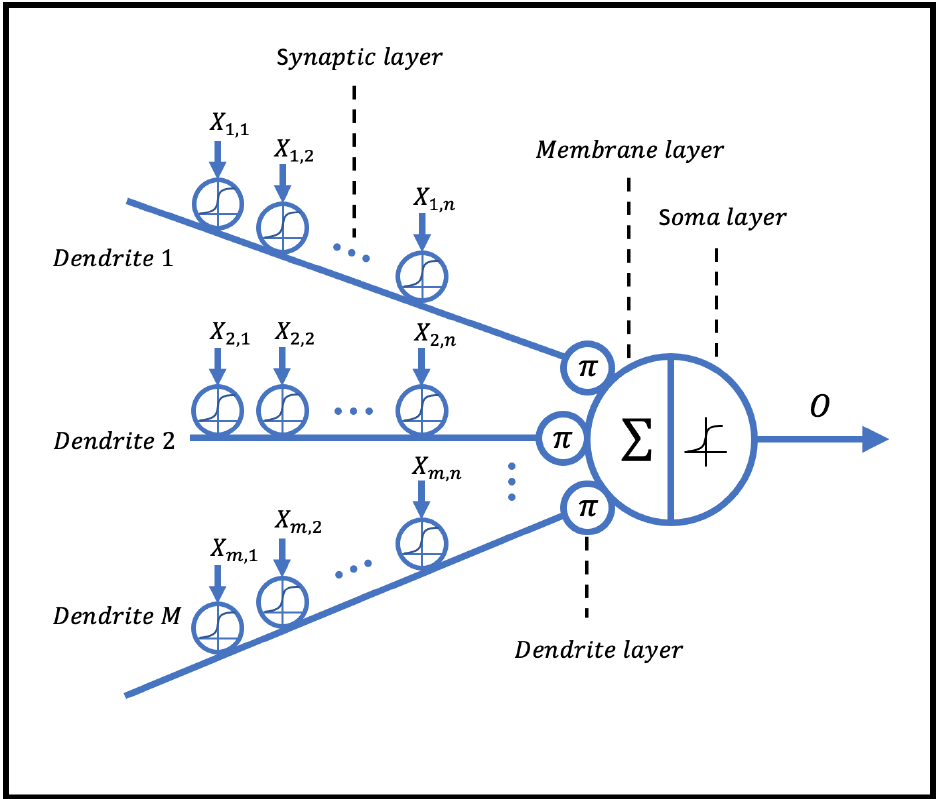
Figure 1. The structure of Dendritic Neuron